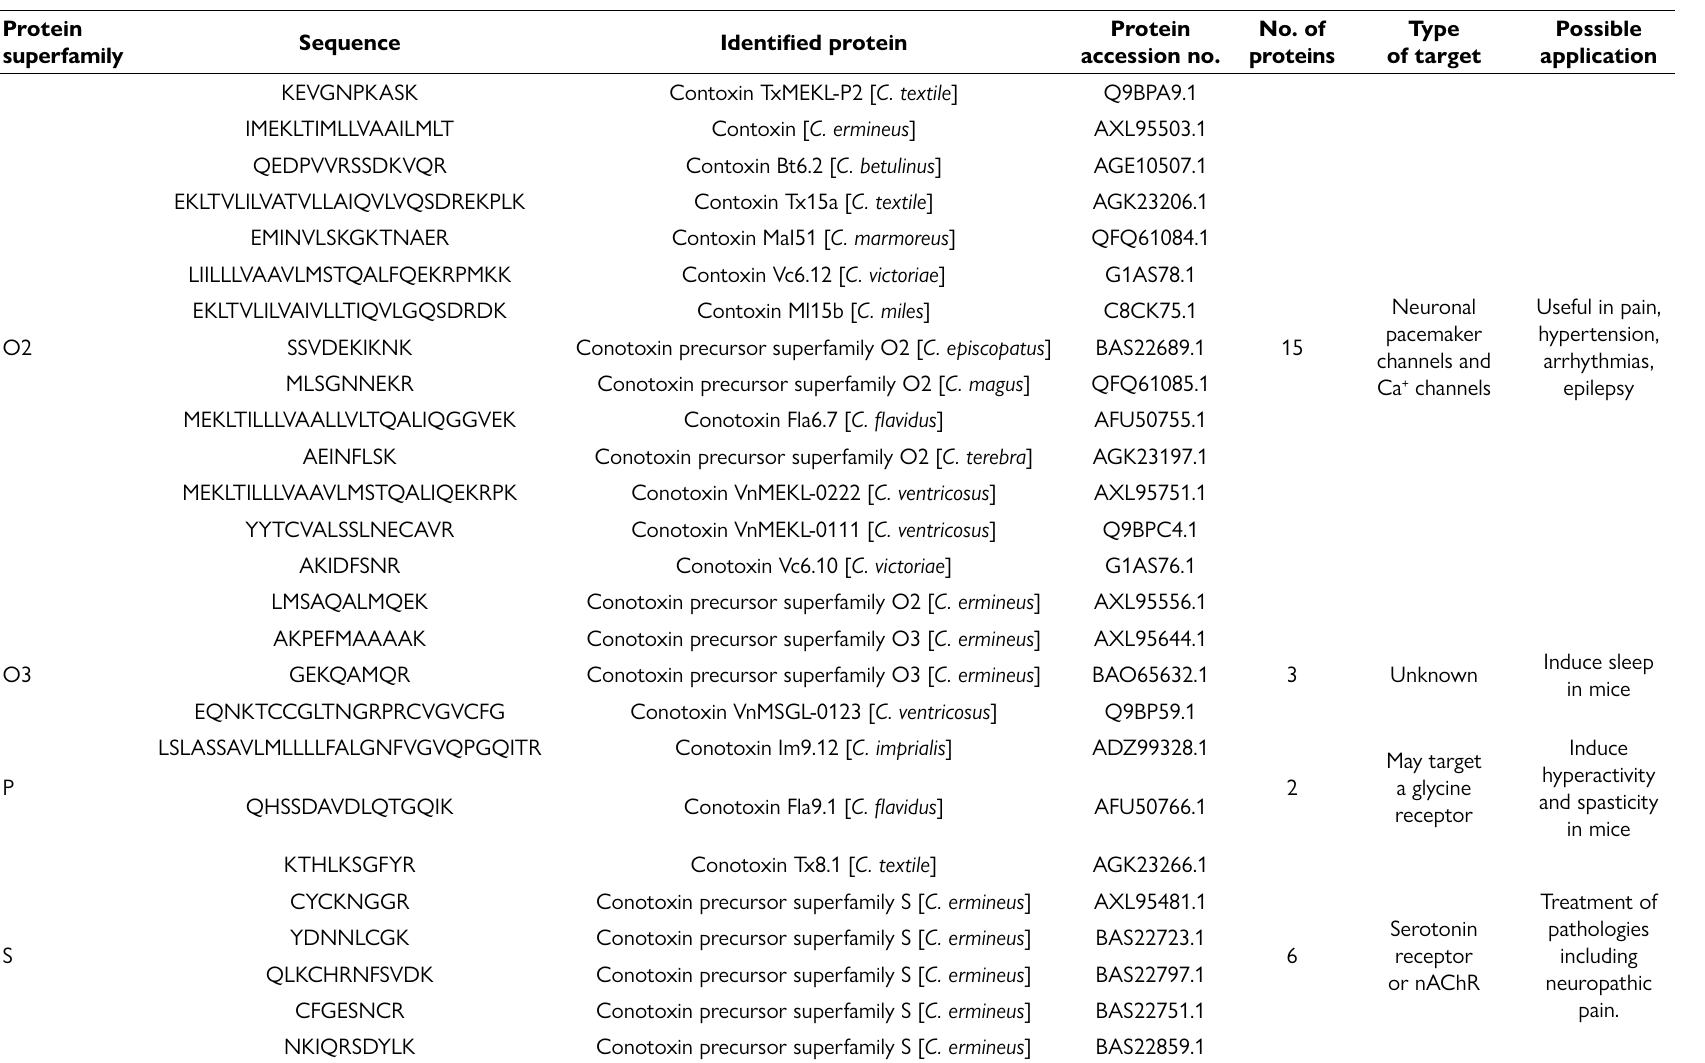
Table 1. Protein superfamily